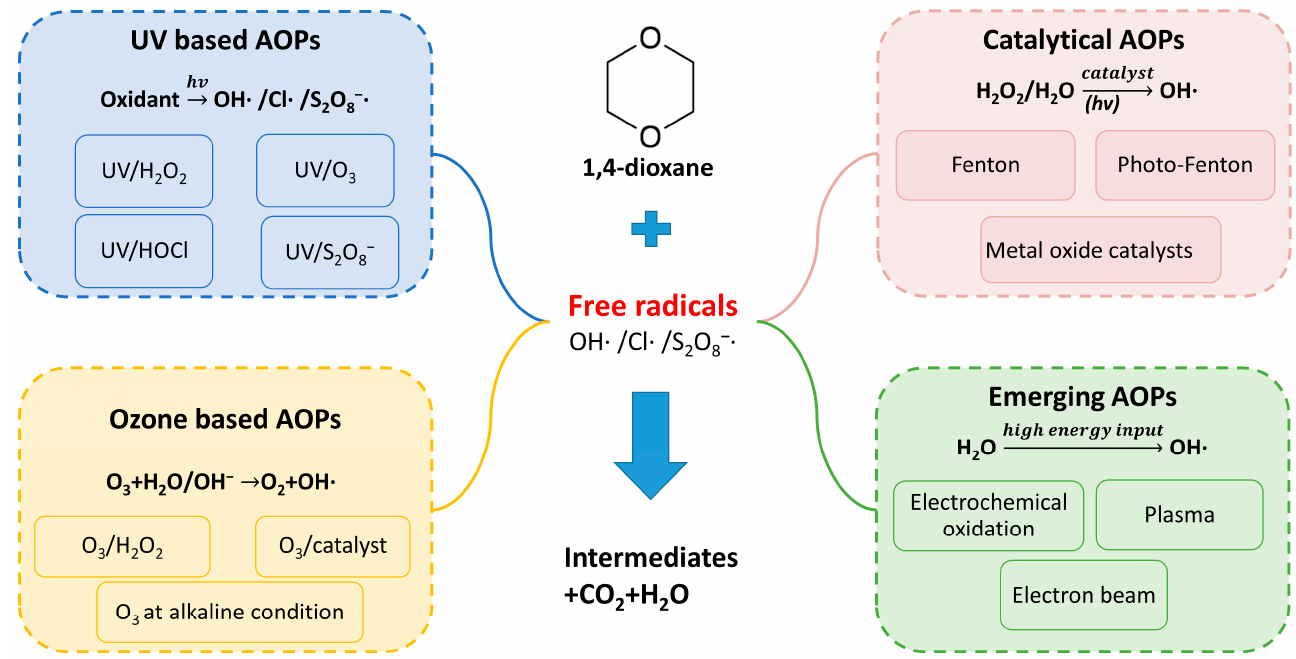
Figure 1. Classification of various AOPs for 1,4-dioxane removal from contaminated water.